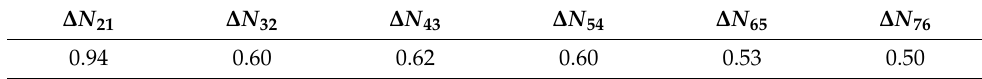
Table 2. Distance between highest seven crests in terms of cycle ratio .